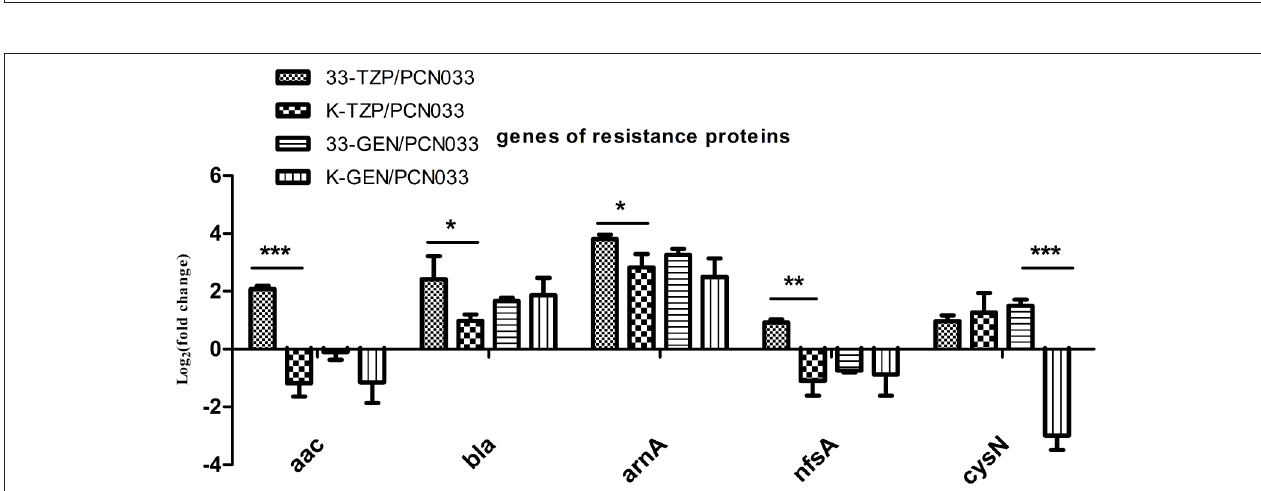
FIGURE 4 | Expression levels of genes that confer resistance, during tazobactam and gentamycin treatment. Expression levels were compared with those of WT (PCN033). 33-TZP/PCN033 indicates the expression levels in PCN033 during tazobactam treatment compared with those in untreated PCN033; K-TZP/PCN033 indicates expression levels in the 1 ppk mutant during tazobactam treatment compared with those in untreated PCN033; 33-GEN/PCN033 indicates expression levels in PCN033 during gentamycin treatment compared with those in untreated PCN033; K-GEN/PCN033 indicates expression levels in the 1 ppk